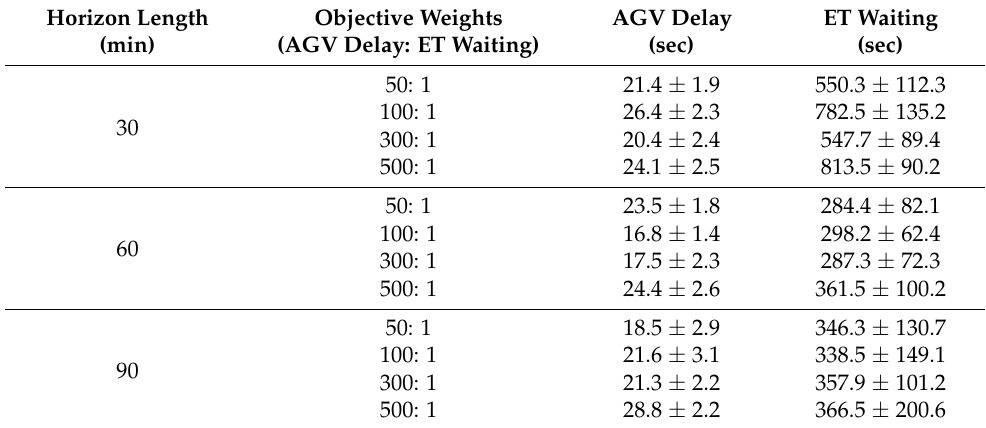
Table 5. Performance of PS by N-RTS with different values of objective weight and horizon length. Horizon